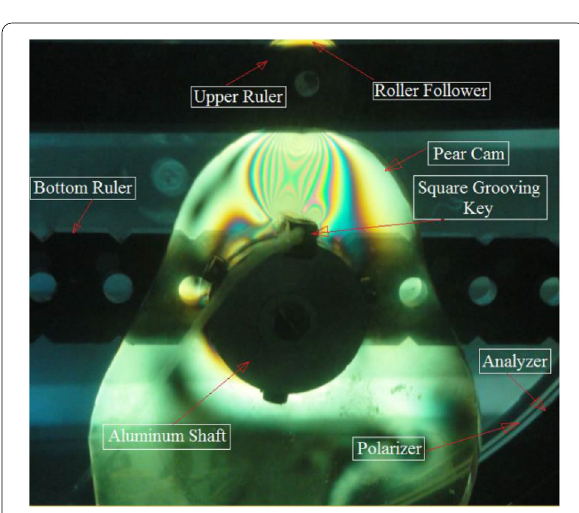
Figure 15 Stress analysis when the follower located at 0° with the cam